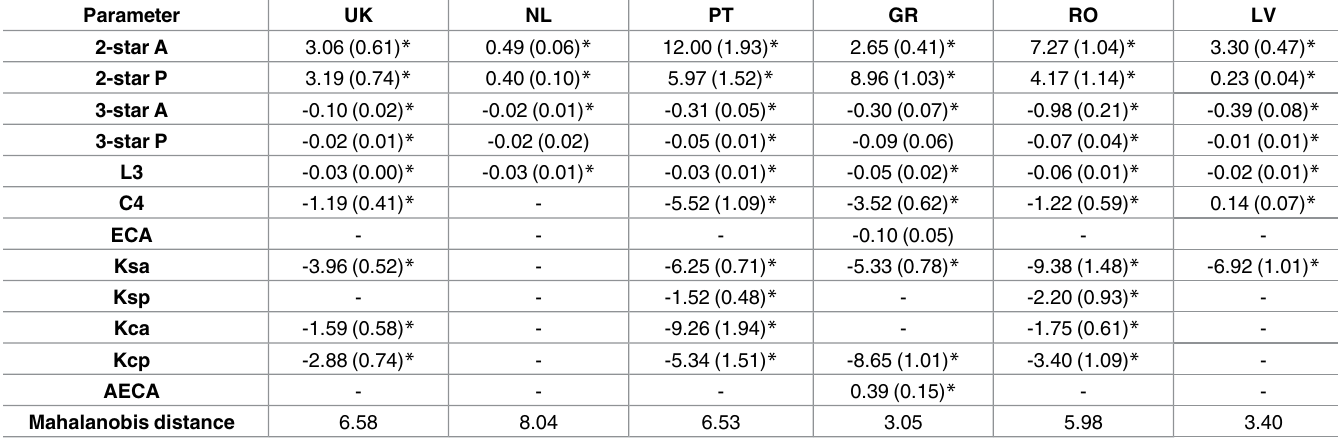
Table 2. Structural ERGMs for selected LIFE Nature partnership